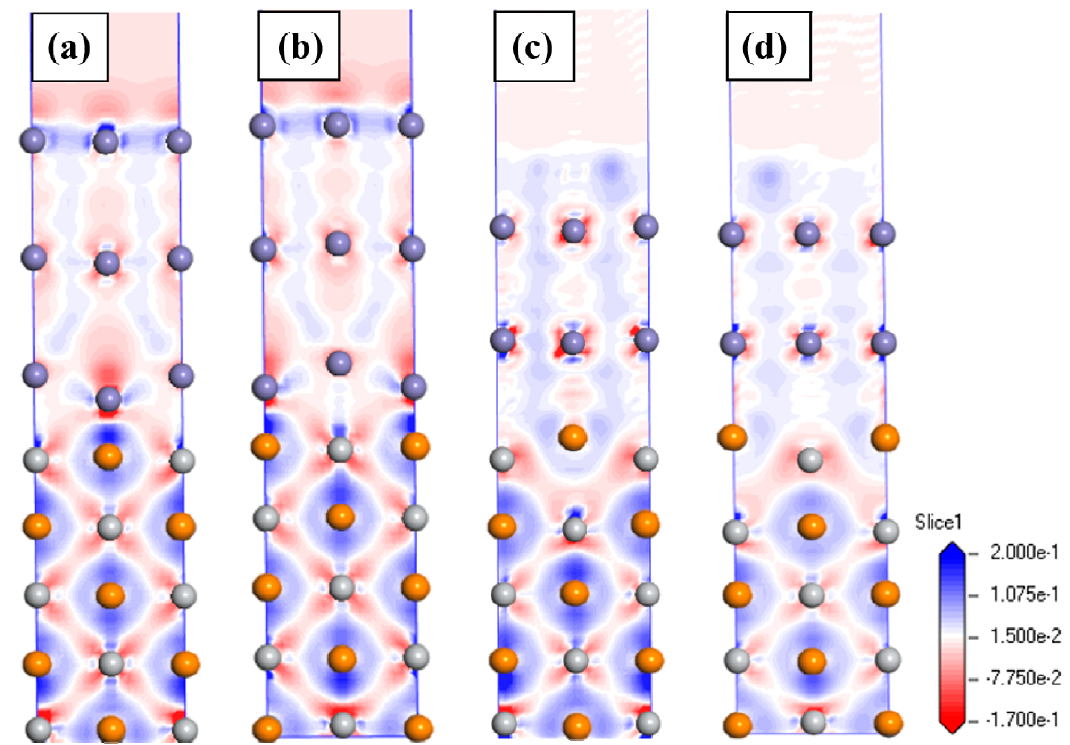
Figure 5. Charge density difference for the TiC (001)/ γ -Fe (001) interfaces: ( a ) Fe-on-C centre; ( b ) Fe-on-Ti centre; ( c ) Fe-bridge-C centre, and ( d ) Fe-bridge-Ti centre.